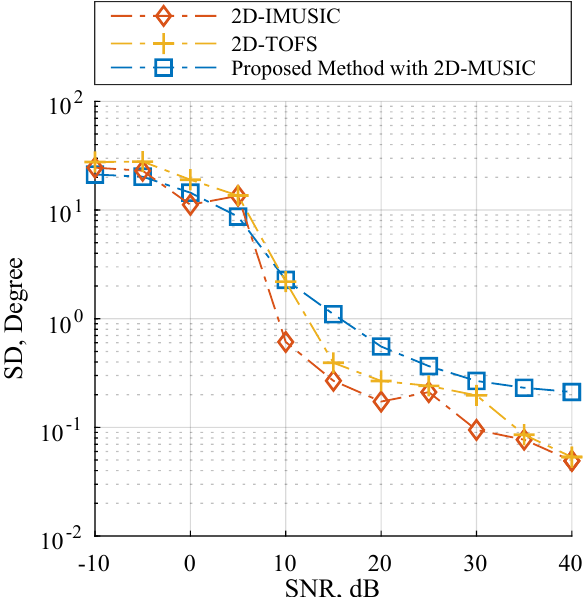
Figure 7. SD estimation performance versus SNR on Scenario 3 where M =